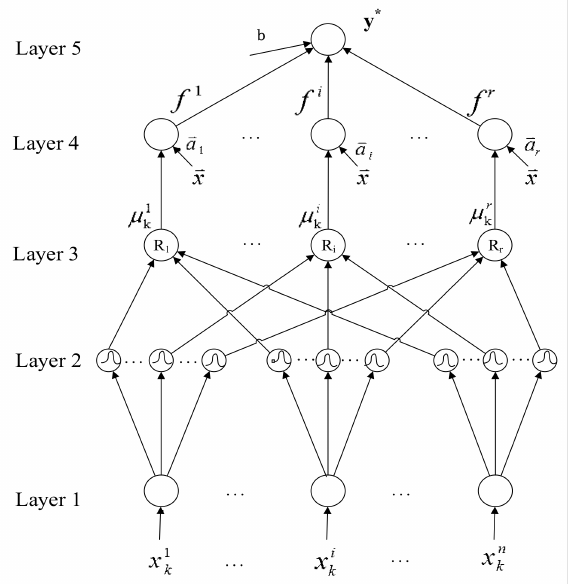
Figure 5. Structure of the self-structuring linear support vector regression algorithm fuzzy network (SSILSVRFN).